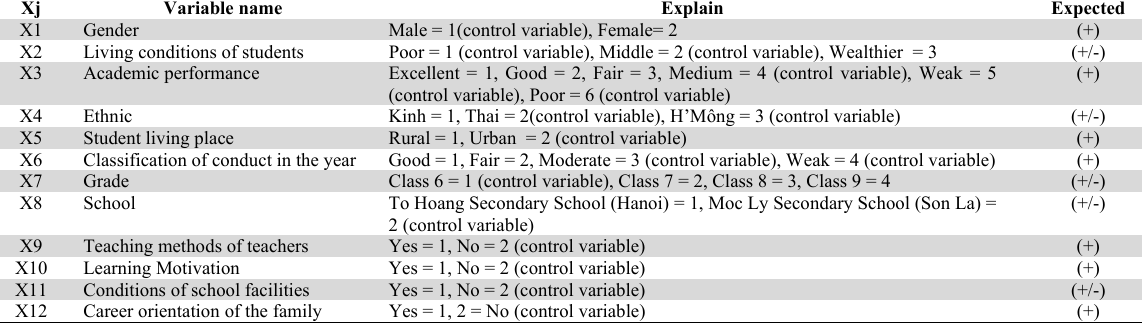
Interpret independent variables in the model of multivariate